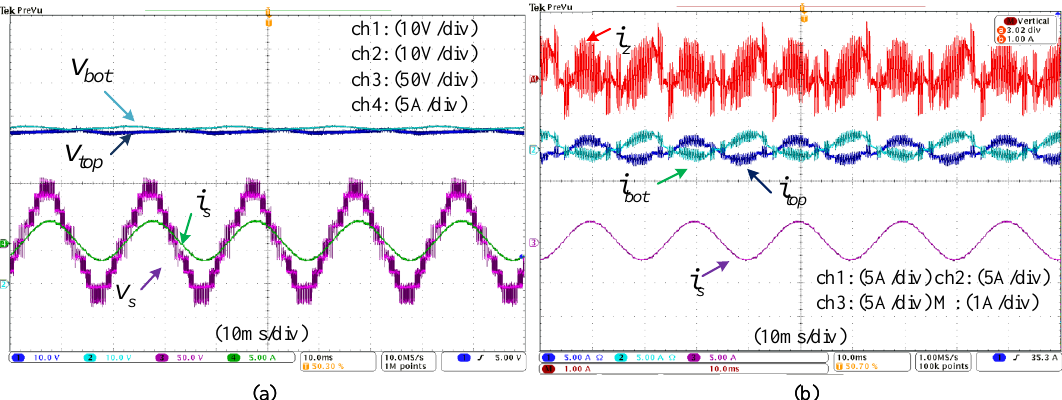
Figure 20. Experiment results with PSC2. ( a ) Phase voltage v s , phase current i s , capacitor voltage of SM v top and v bot ; ( b ) circulating current i z , phase current i s , arm current i top and i bot